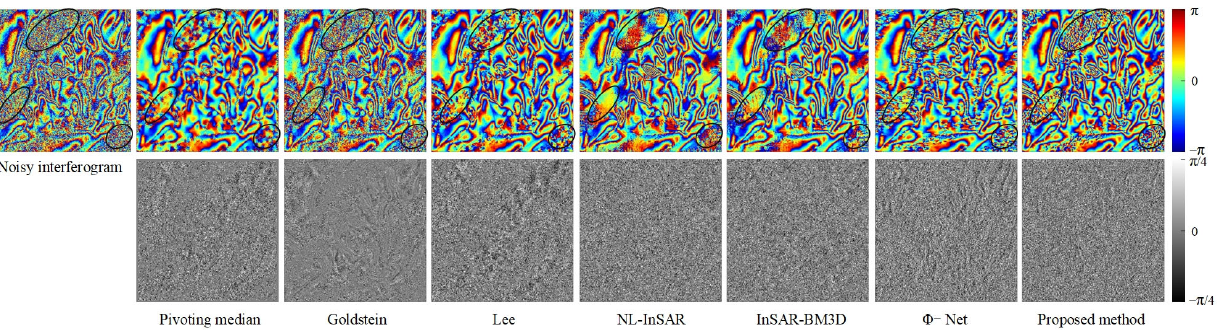
Figure 7. Filtered and unwrapped results for real data from L’Aquila, Italy. The first row shows the filtered interferogram. The second row shows the noise image; the visibility of the phase fringe traces in the noise image indicates the phase filtering method’s ability to preserve detail.